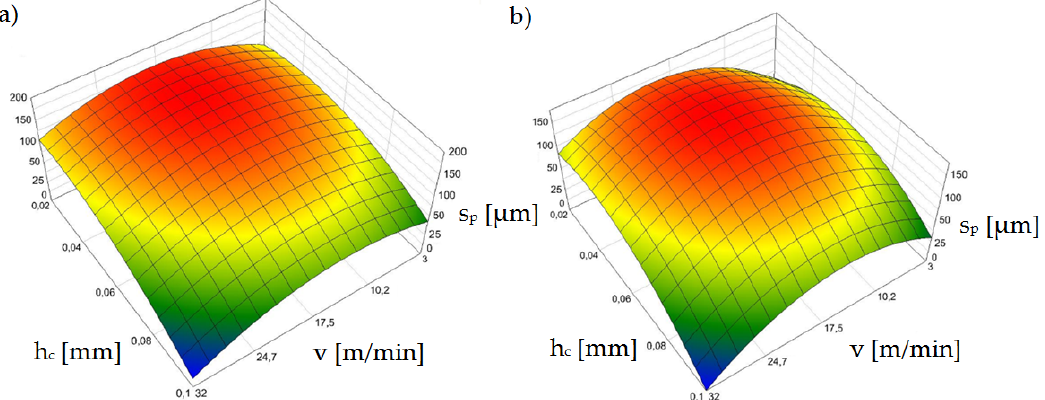
Figure 11. Graph of the dependence of the width of the sheared burnished zone ( s p ) on the cutting speed ( v ) and the horizontal clearance ( h c ): ( a ) uncoated material, ( b ) coated material .